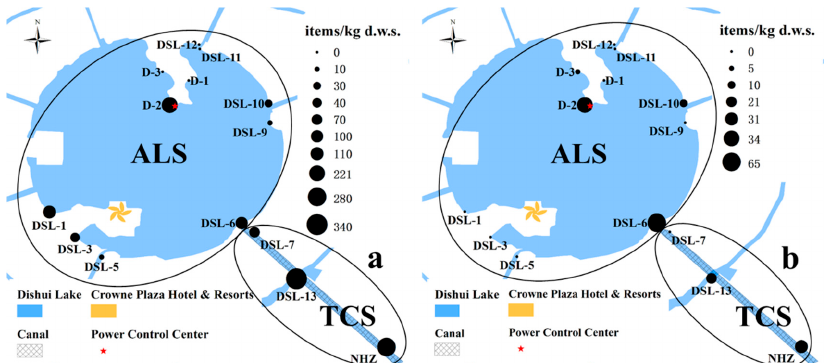
Figure 2. Abundance and distribution of microplastics ( a ), mesoplastic and macroplastic ( b ) in Dishui Lake sediment. ALS: Sampling sites around the Dishui Lake, including sites in the north (D1, D2, D3, DSL-11, and DSL-12), the east (DSL-9 and DSL-10), and the south (DSL-1, DSL-3, and DSL-5). TCS: Sampling sites int the canal connecting the lake to the East China Sea (DSL-6, DSL-13 and NHZ). Appl. Sci. 2020 , 10 , x FOR PEER REVIEW